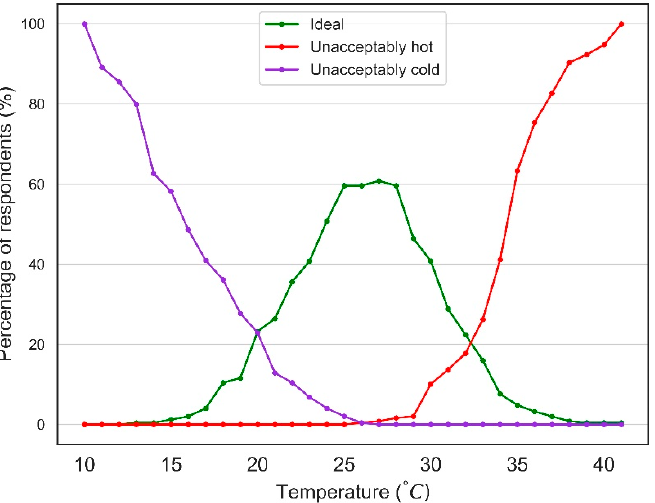
Figure 6. Percentage of respondents perceiving a specific temperature as ideal (green line), unacceptably hot (red line), and unacceptably cold (blue line).